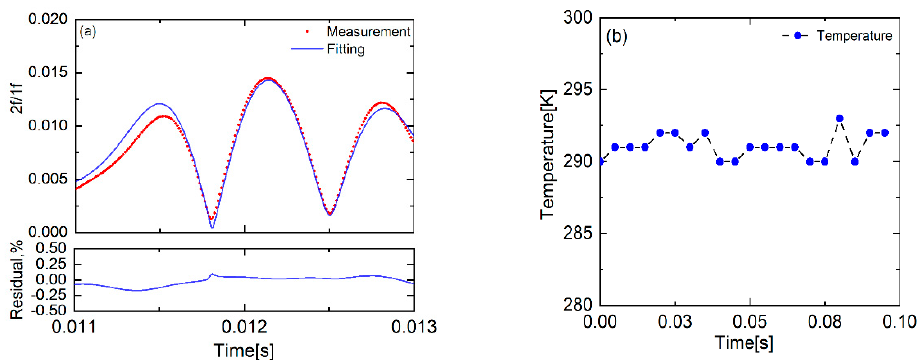
Figure 6. ( a ) The measured and the best-fit WMS − 2f/1f spectral profile. ( b ) The inferred temperature in room conditions by the WMS − 2f/1f strategy.